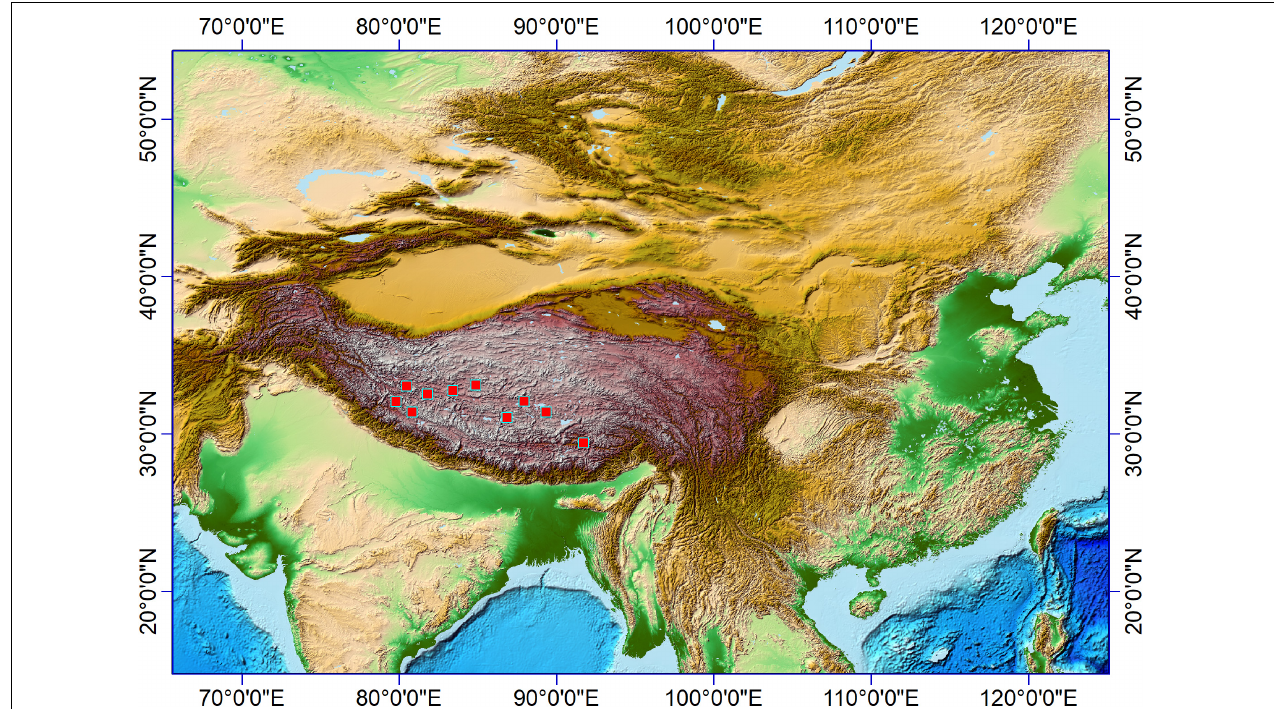
FIGURE 1 | A map showed the Tibet Plateau and the surrounding regions. The red box shows the sampling sites.